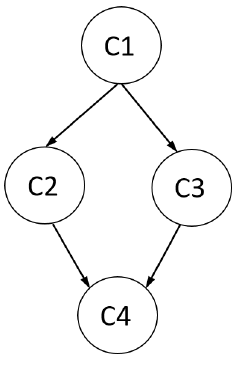
Figure 2. Illustration of a partial order with four latent